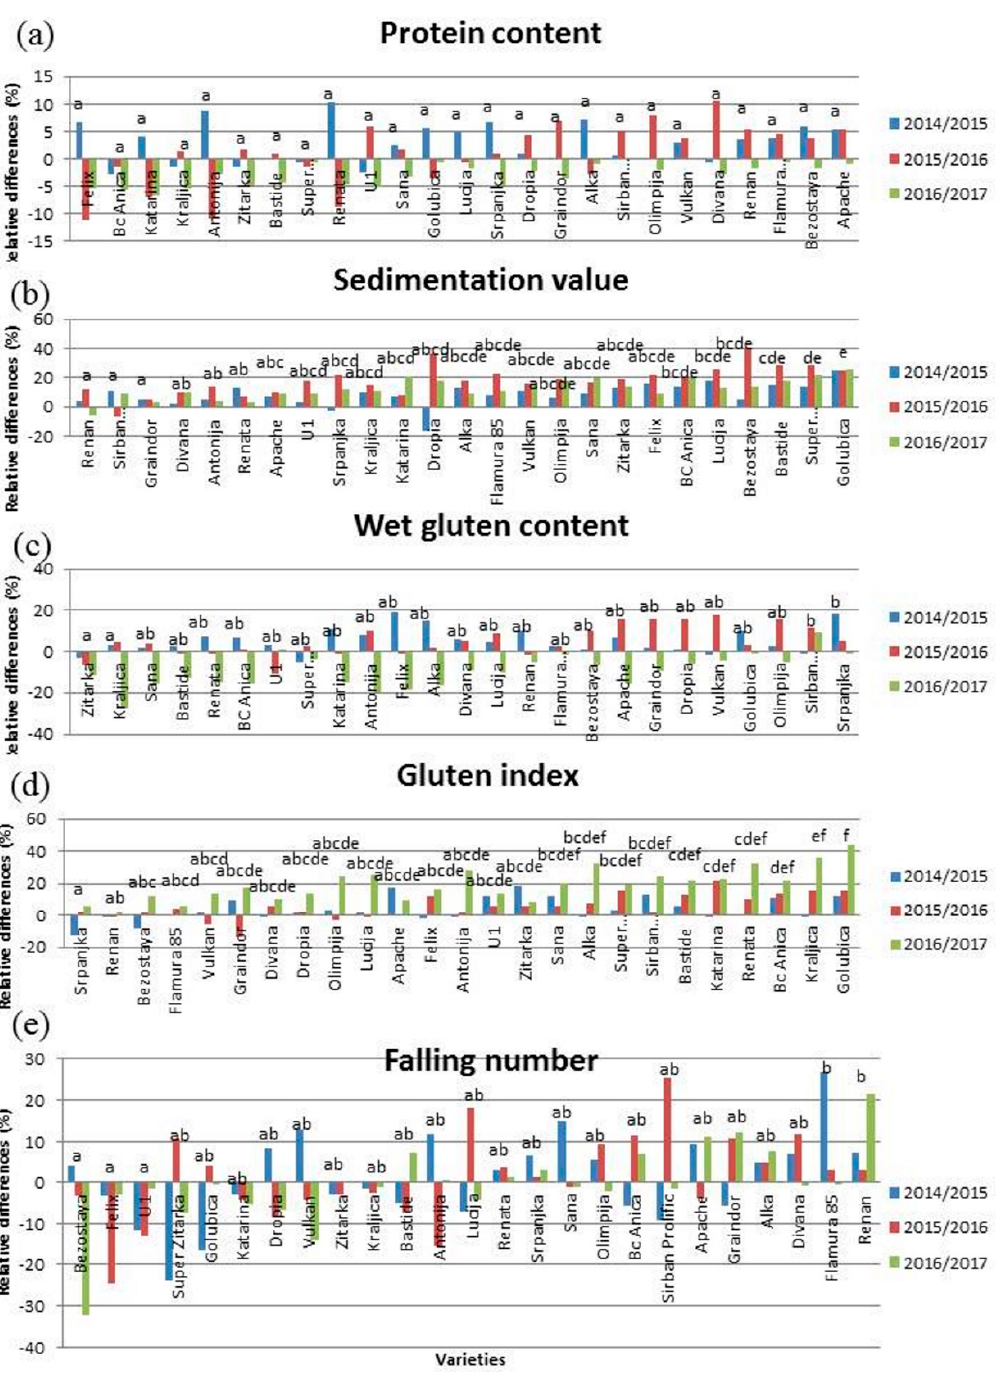
Figure 4. Relative differences in technological quality parameters (protein content ( a ), sedimentation value ( b ), wet gluten content ( c ), gluten index ( d ), and falling number ( e )) between FHB-inoculated and naturally infected plants in the three years of the study (2014/2015, 2015/2016, and 2016/2017) for 25 winter wheat varieties. Different lower-case letters represent significantly different values ( p < 0.05) for each wheat variety in the three years, on average.